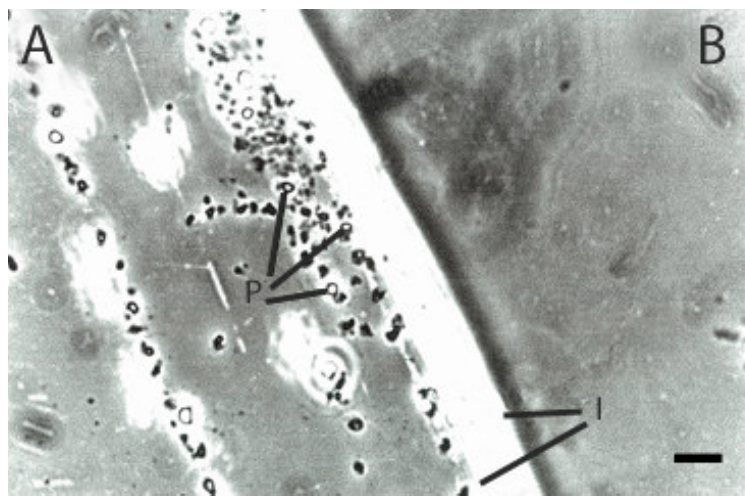
FIGURE 5. Phase contrast micrograph showing the interface (I) between a cell suspension of the w-t (A) and benzene (B). After only 10-min exposure to benzene, cells are shown to have formed into protoplasts (P) and appear in greater numbers nearest to the interfacial boundary. Bar = 5 µm.